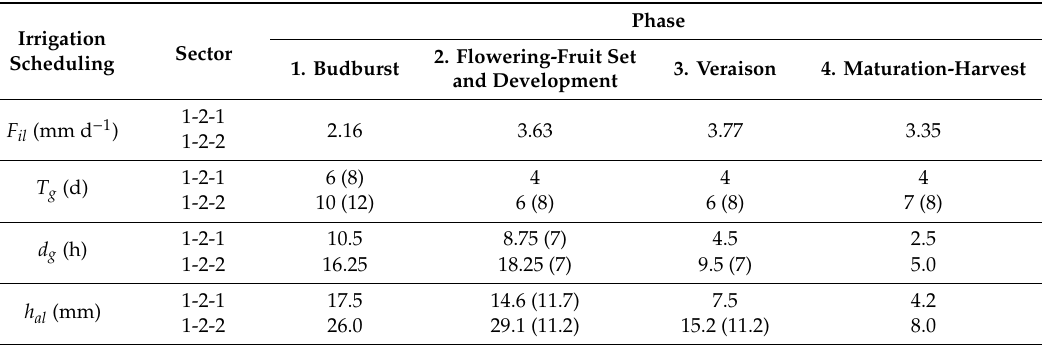
Table 4. Initial irrigation schedule calculated for the two VRI sectors; for each of the four phases described in Section 3.2, irrigation water requirement ( F il , mm d − 1 ), turn ( T g , d, calculated on the basis of the 4-day irrigation turn imposed by the irrigation consortium), duration ( d g , h) and depth provided ( h al , mm) are reported. In brackets the values modified on the basis of the constraints imposed by